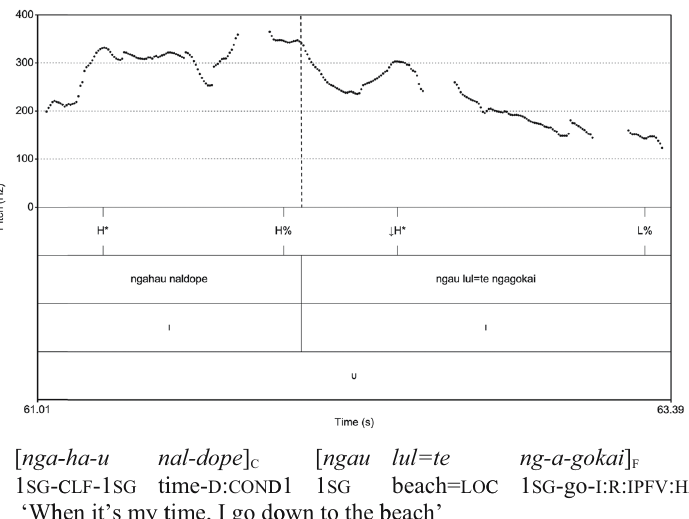
Figure 3: Adverbial clause with H*